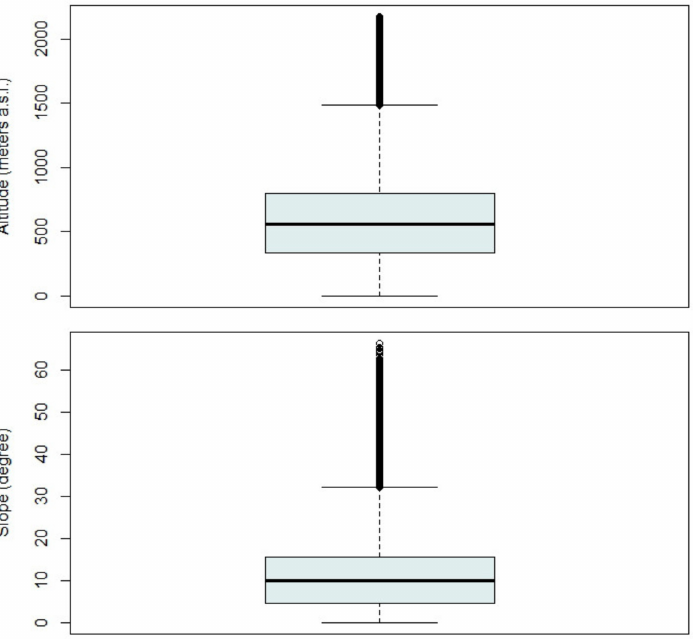
Figure 11. Box plots of topographical parameters (altitude and slope) for forest area cleared before 1950. Circles specify outliers; the horizontal lines within the box specify the median value of each parameter. The bottom of the box is at the first quartile (25% of the distribution), and the top is at the value of the third quartile (75% of the distribution), while the whiskers indicate variability outside the upper and lower